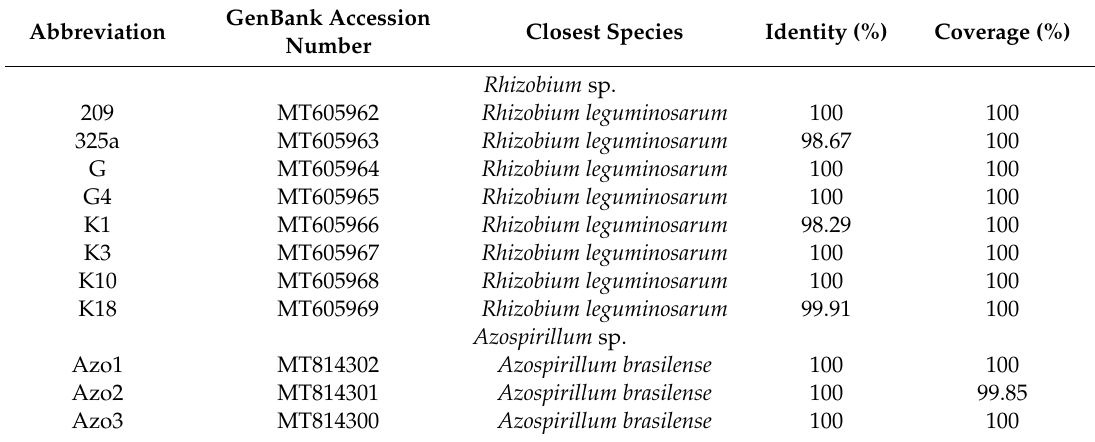
Table 2. Data on the identification of bacteria strains used in this